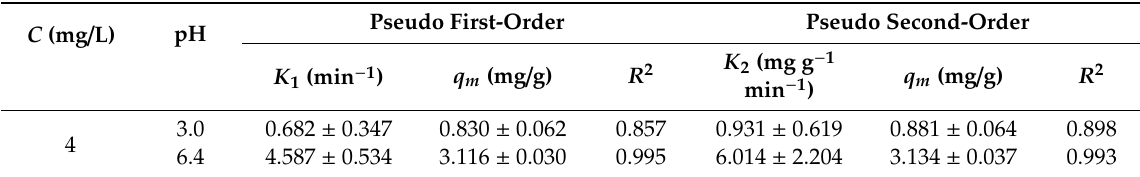
Table 6. Adsorption kinetics